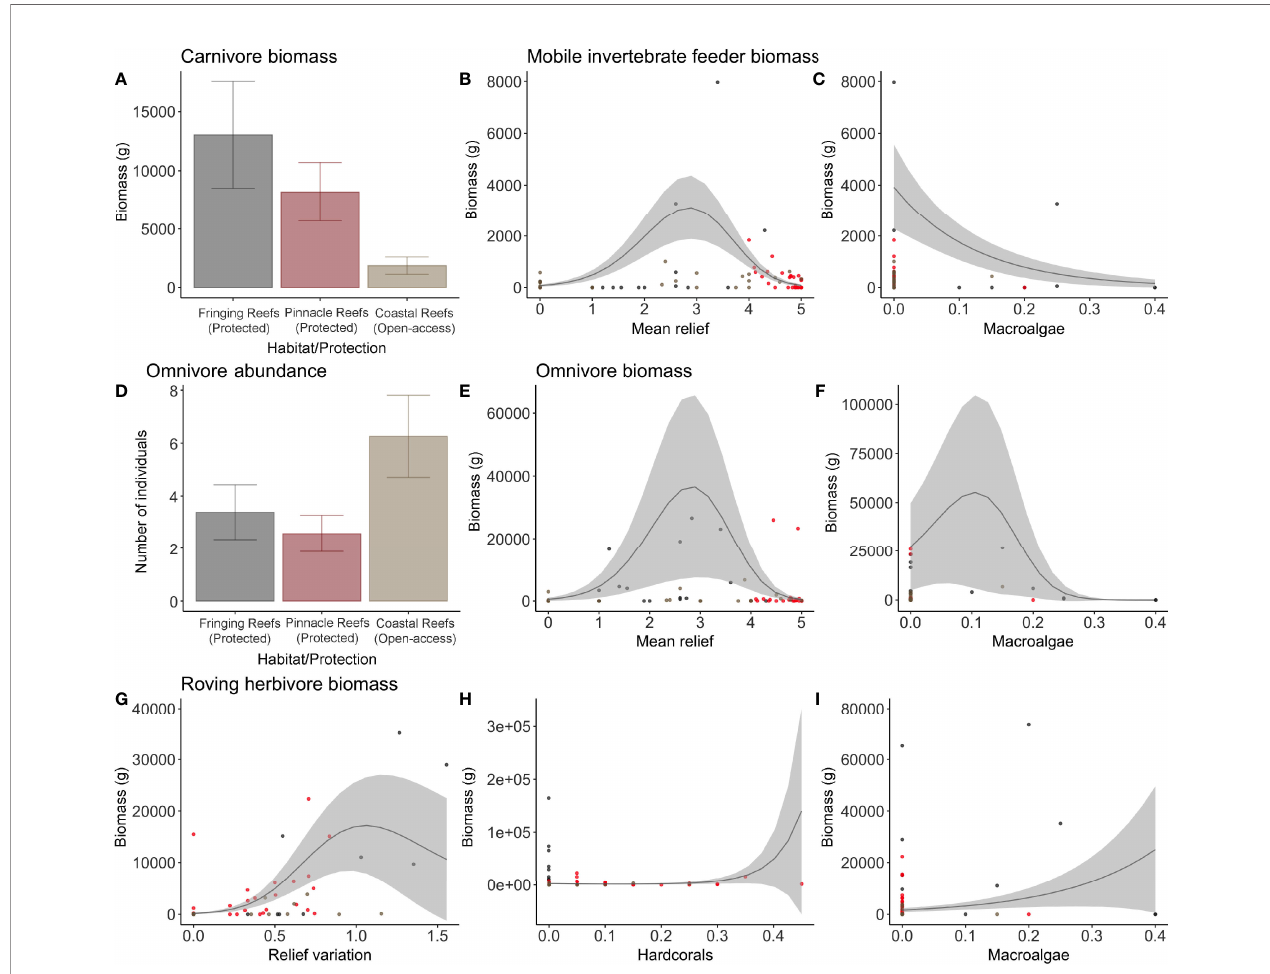
FIGURE 4 | Plots of the most parsimonious models for the biomass (grams) of carnivores (A) , mobile invertebrate feeders (B, C) , omnivores (E, F) , and roving herbivores (G – I) , and abundance of omnivores (D) . Each dot represents a sample: the gray dots represent the Fringing Reefs, red dots the Pinnacles Reefs, and beige the Coastal